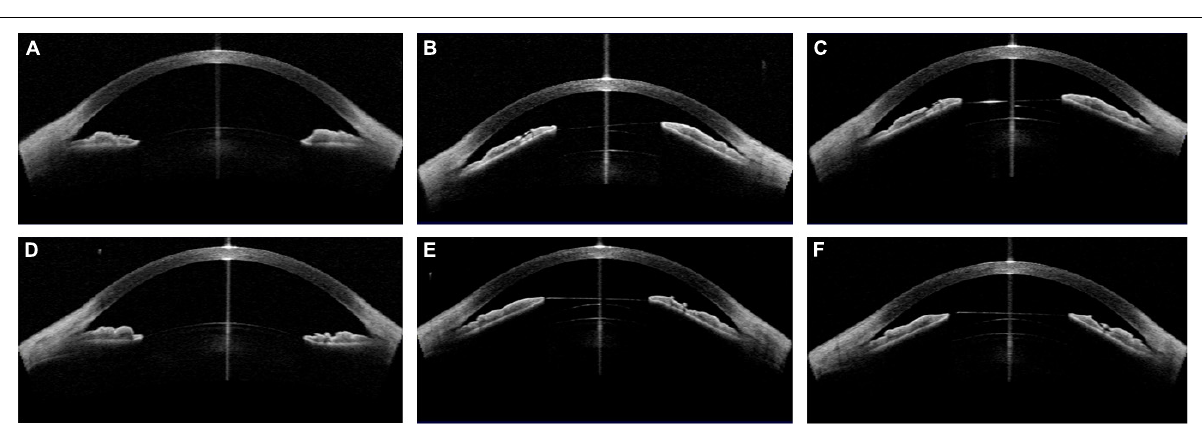
FIGURE 7 | Case 4: (A,D) Convex shape iris before surgery; (B,E) 1 month after ICL implantation (B oblique position, E vertical position); (C) the vault value decreased after changing the ICL into a vertical position; (F) 2 month after ICL implantation. (Row 1: right eye; Row 2: left